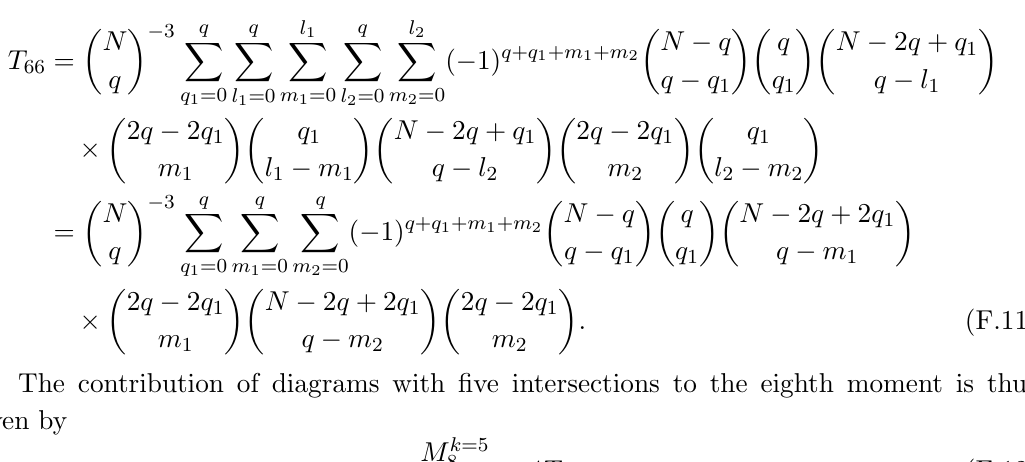
Figure 15 . The diagrams with (cid:12)ve intersections contributing to the 8th moment as T 66 which is a new type of